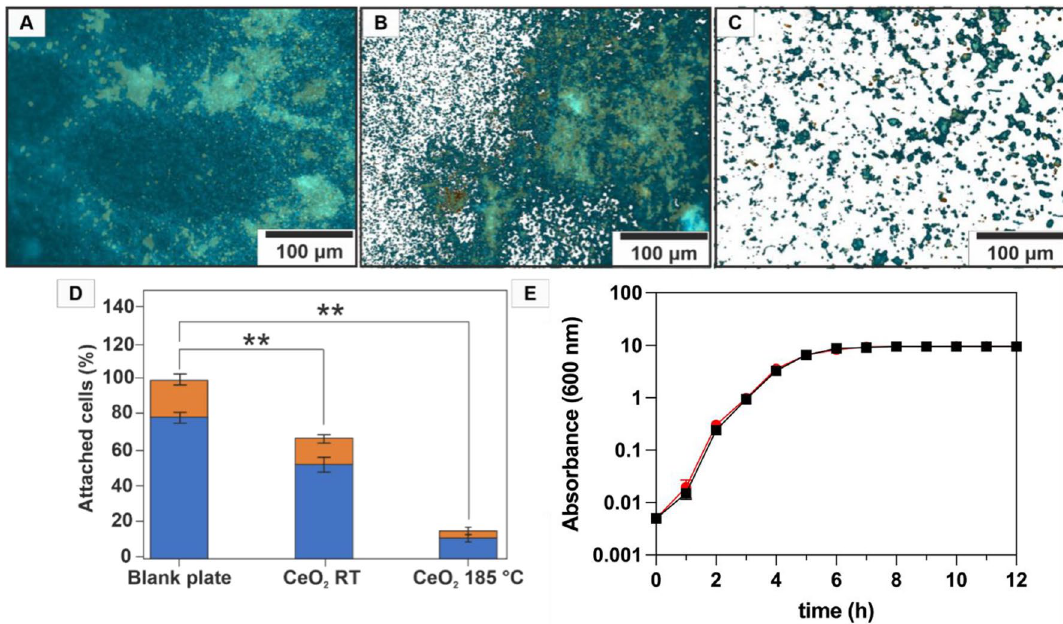
Figure 7. Effect of CeO 2 -coated PC surfaces on cell adhesion and growth of P. aeruginosa PA14. The bacteria were cultivated for 72 h under gentle shaking (150 rpm) at 30 °C on non-coated and coated CeO 2 /PC composites. The planktonic cells were removed, and the remaining bacteria attached to the surfaces were stained with SYTO 9 and propidium iodide for 30 min at 30 °C. The surfaces were then analyzed by epifluoresence surface microscopy. The pictures show bacterial attachment on ( A ) non-coated, on ( B ) CeO 2 RT/PC and ( C ) CeO 2 185 °C/PC composites. The effect of the incorporated CeO 2 NPs on bacterial biofilm formation was quantified by analyzing three different squares of 300 µm × 400 µm in size by quantifying the portion of green (SYTO 9) and red fluorescence color (propidium iodide) representing ( D ) total and live cells (blue) count and respectively dead cells (orange). The asterisks (**) indicate statistically significant differences with a p -value smaller than 0,001. ( E ) Growth curve of P. aeruginosa with (black) and without (red) addition of 2% (w/v) CeO 2 . Error bars represent standard deviation of three independently performed